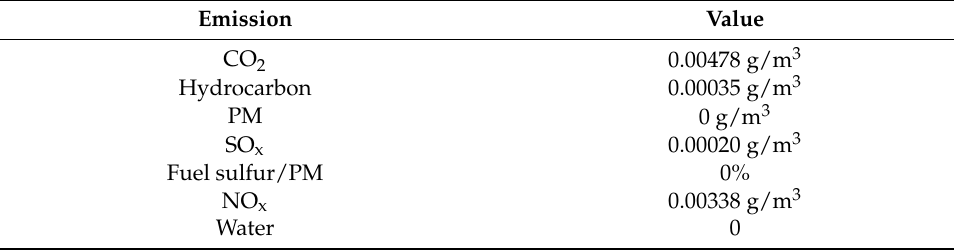
Table A6. C65 microturbine emission [44–47].